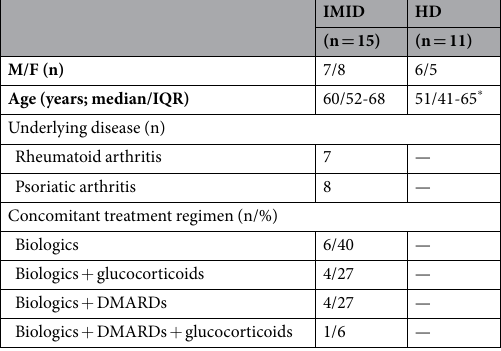
Table 1. Demographics and clinical characteristics of the patients after eight years of anti-TNF biological treatment. * Statistical analysis was performed using the Mann-Whitney test (p = 0.15). Note: IMID = immune- mediated inflammatory diseases; HD = healthy donors; IQR = interquartile range; DMARDs = disease modifying anti-rheumatic drugs (include methotrexate and